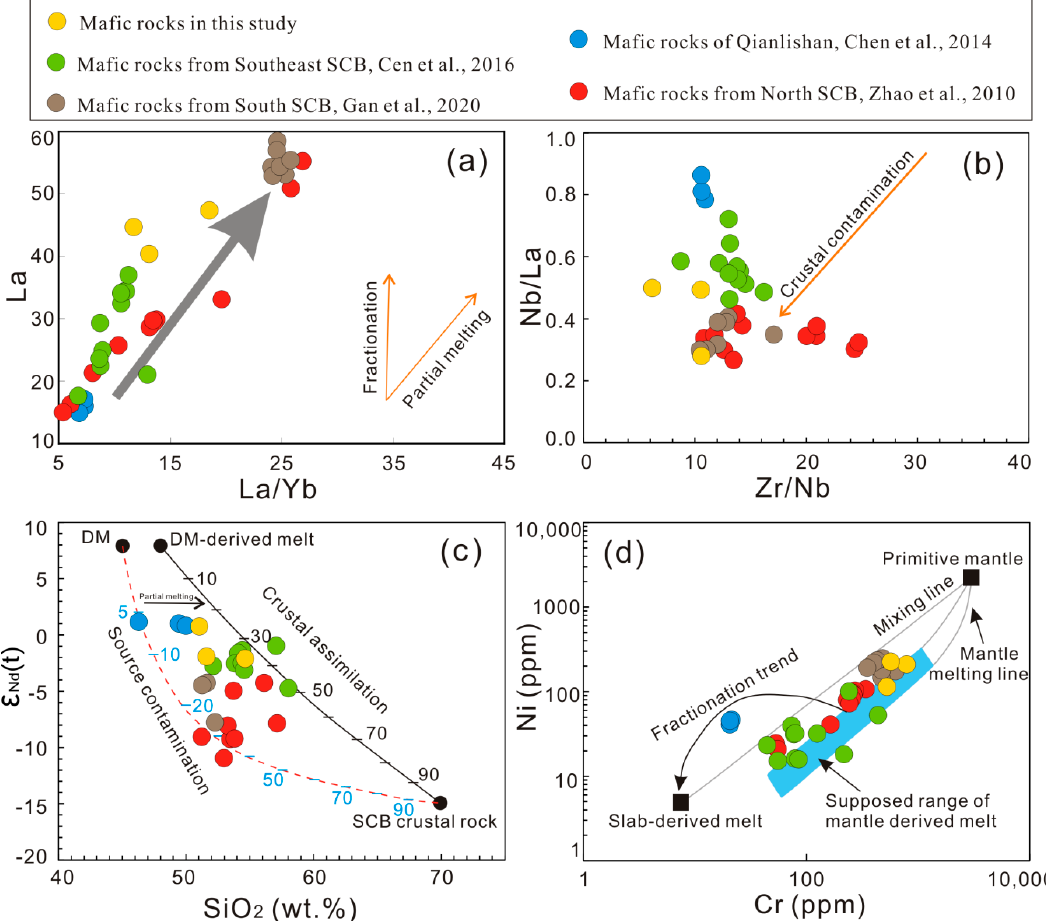
Figure 13. Plots of ( a ) La vs. La/Yb, ( b ) Nb/La vs. Zr/Nb, ( c ) ε Nd(t) vs. SiO 2 , and ( d ) Ni vs. Cr [39] for the Qianlishan and the SCB mafic rocks: cited data are the same as in Figure 11. The DM in (c) is marked by SiO 2 = 45 wt.%, Nd = 4.0 ppm, ε Nd(t) = +8.0, and Nb/La = 0.75; its derivation is marked by SiO 2 = 48 wt.%, Nd = 20 ppm, ε Nd(t) = +8.0, and Nb/La = 0.75; and the SCB crustal rock is marked by SiO 2 = 70 wt.%, Nd = 26.3 ppm, ε Nd(t) = − 15.0, and Nb/La = 0.32. The fi elds for di ff erent rocks in (d) are from Zhang et al. [86] and the references therein.